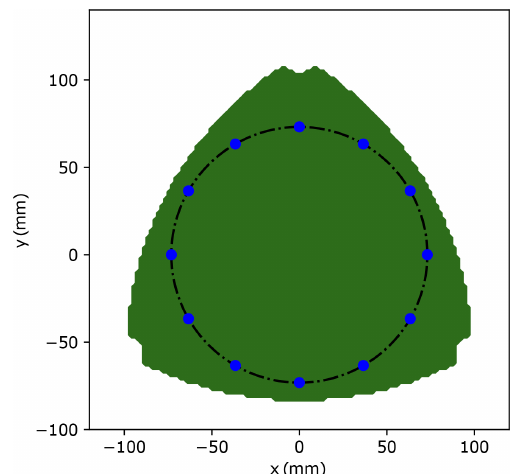
Figure 12. Workspace of the selected PPM for l 0 = 200, l 1 = 105, and l 2 =